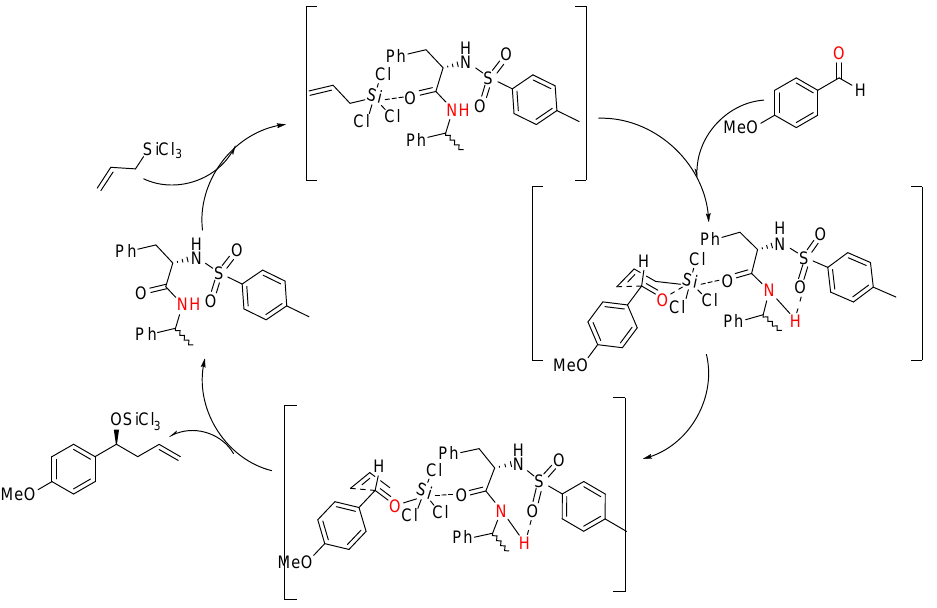
Figure 12. Reaction course for chiral allylation of aldehydes.